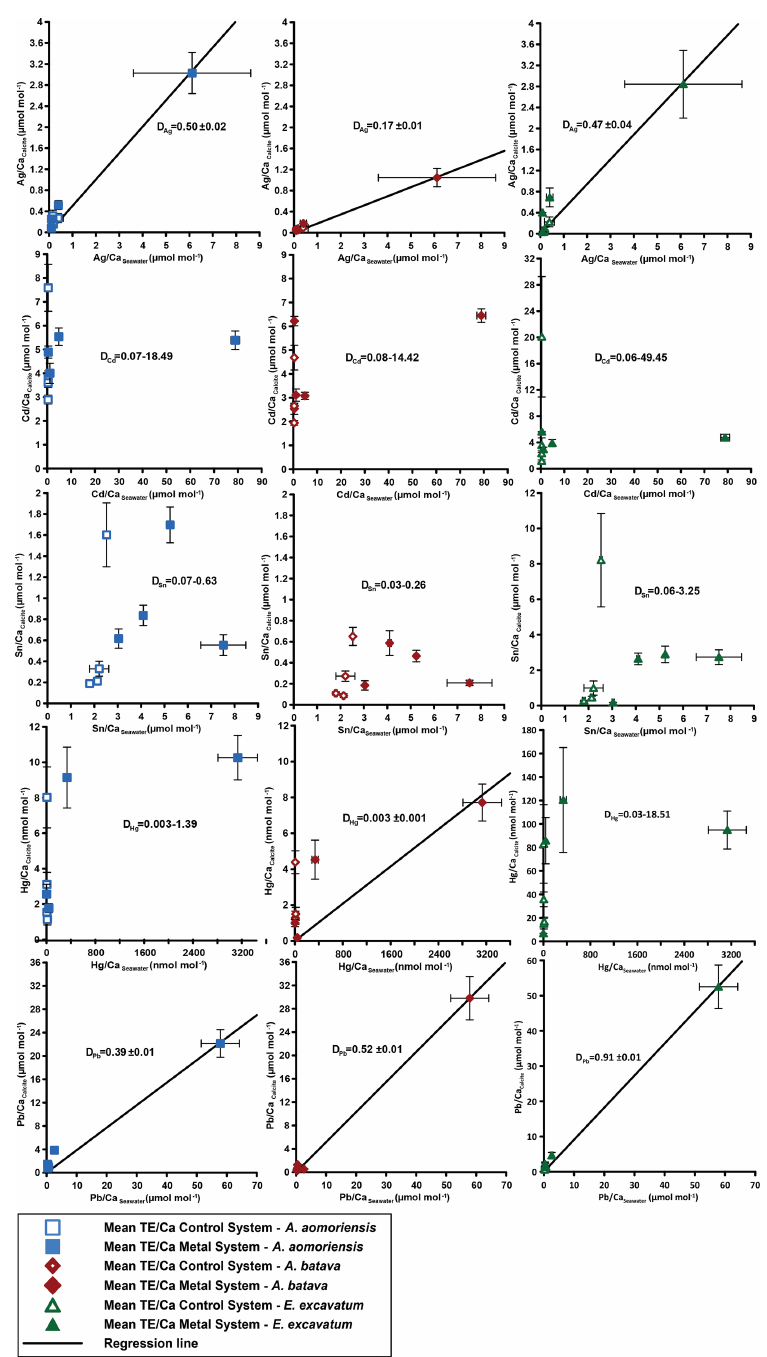
Figure 4. Mean TE / Ca values in the foraminiferal calcite versus the mean TE / Ca values in the corresponding culturing medium based on phase 0 to 3. Each data point represents the mean value of all laser ablation ICP-MS measurements on single foraminiferal chambers built up during the individual culturing phase plotted against the mean metal concentrations in the seawater averaged over the culturing phase (Table 3). Because calculating p and r 2 values of the regression lines and the D TE ’s with the mean per phase resulted in comparable values to when calculating with the overall dataset, we considered this approach adequate. Error bars symbolise the standard error of the mean. The linear regression line ( ± standard deviation) is displayed when elements showed a significant correlation between seawater and calcite. D TE ’s of E. excavatum were considered without values for phase 0 of the metal system as only data from one newly formed chamber were available. All values can be found in Table 4. An enlarged graph based on the calculations without phase 3 is provided in the Appendix (Fig.